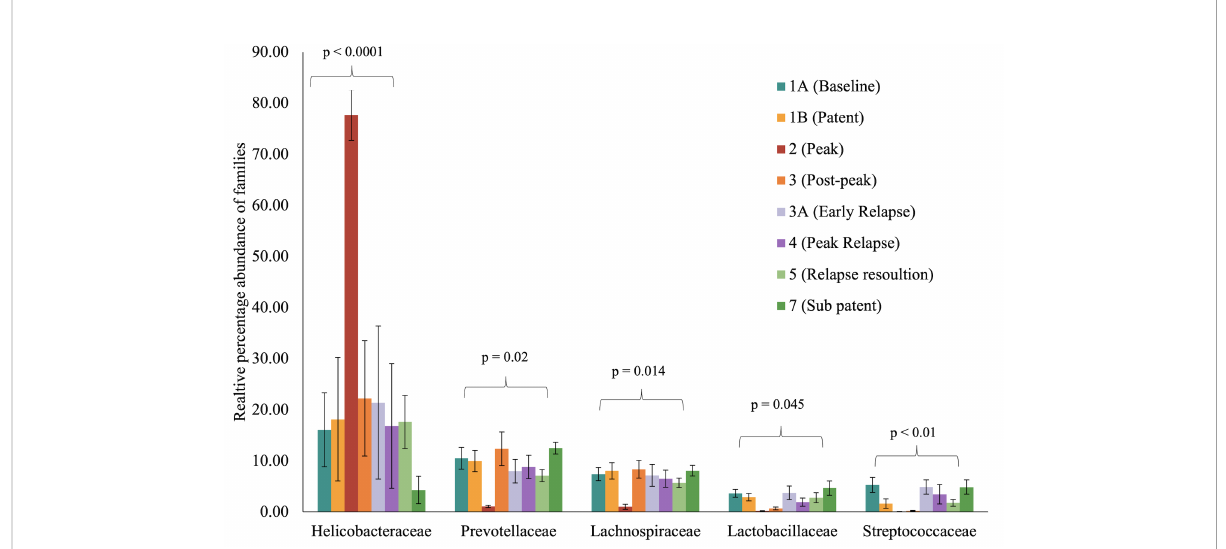
FIGURE 5 Selected bacterial families with signi fi cant variance during malarial infection in rhesus macaques study model. The data (mean ± SE) for relative percentage sequence abundance of each family at each timepoint were compared using one-way analysis of variance repeated measures (ANOVA) test (p ≤ 0.05). P-value denotes the result of the ANOVA comparing all TPs for one